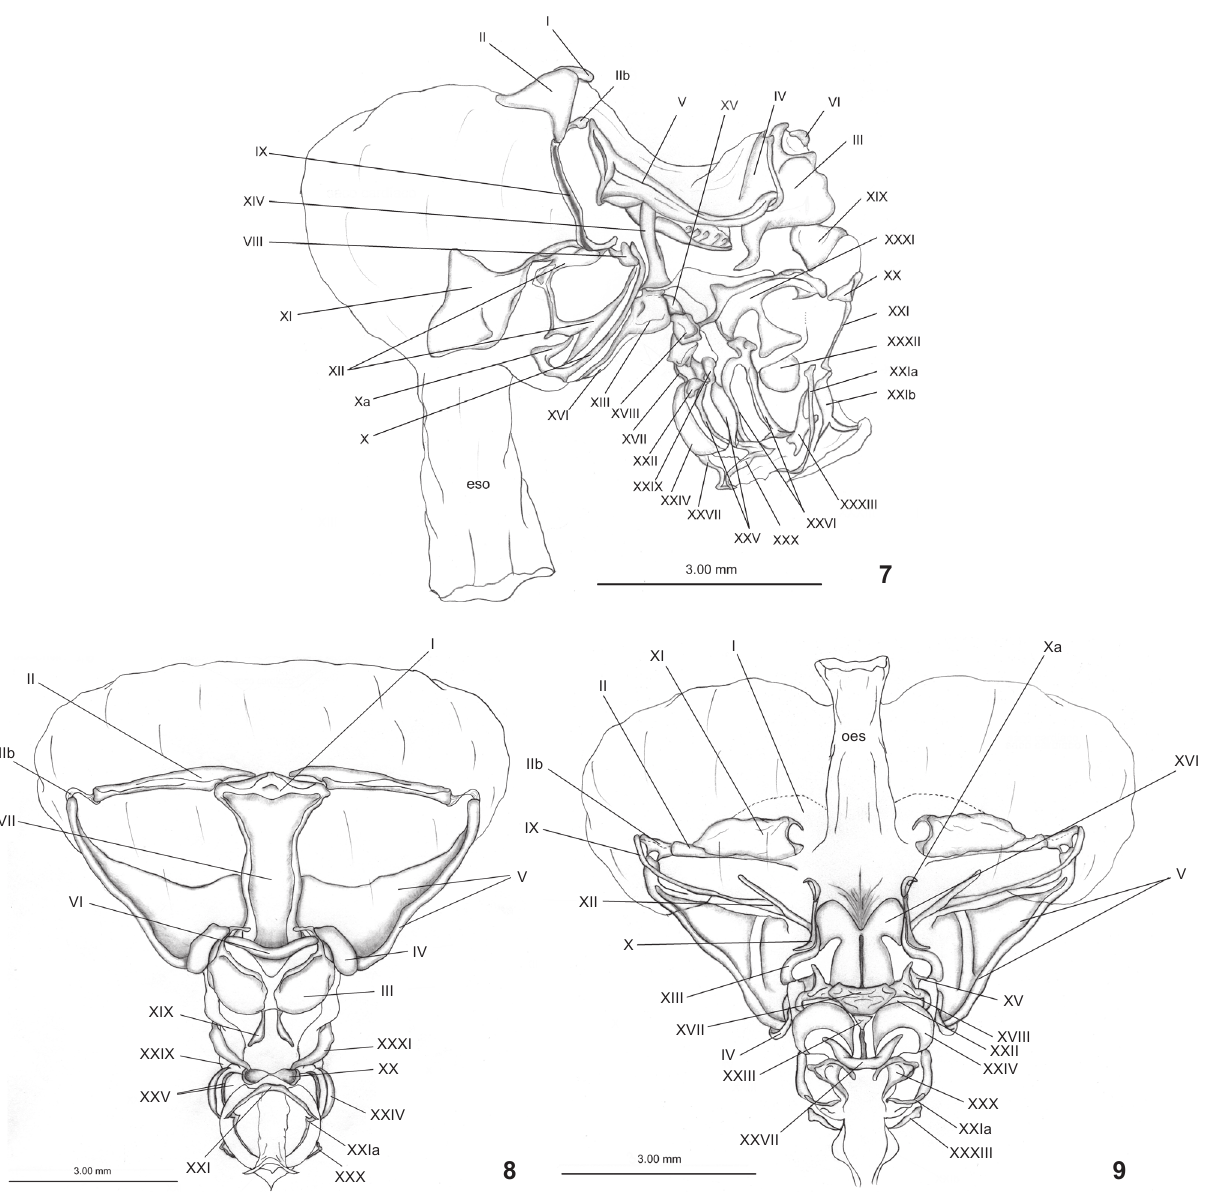
Figures 7-9. Valdivia serrata , cardiac and pyloric chambers of the foregut: (7) lateral view; (8) dorsal view; (9) ventral view. Mesocardiac ossicle (I), pterocardiac ossicle (II), postpterocardiac ossicle (IIb), pyloric ossicle (III), exopyloric ossicle (IV), zygocardiac ossicle (V), propyloric ossicle (VI), urocardiac ossicle (VII), pectineal ossicle (VIII), prepectineal ossicle (IX), postpectineal ossicle (X), ‘Quill’ of the postpectineal ossicle (Xa), anterior lateral cardiac plate (XI), posterior lateral cardiac plate (XII), inferior lateral cardiac ossicle (XIII), subdentate ossicle (XIV), lateral ossicle of the cardio-pyloric (XV), ossicle of the cardio-pyloric valve (XVI), cardio-pyloric valve (cpv), anterior ossicle of the cardio-pyloric valve (XVI), posterior ossicle of the cardio-pyloric valve (XVII), lateral ossicle of the cardio-pyloric valve (XVIII), anterior mesopyloric ossicle (XIX), posterior mesopyloric ossicle (XX), uropyloric ossicle (XXI), infra-uropyloric fragment (XXIa), posterior uropyloric ossicle (XXIb), preampullary ossicle (XXII), anterior inferior pyloric ossicle (XXIII), inferior ampullary ossicle (XXIV), ampullary roof ossicle, lower portion ossicle (XXV), ampullary roof ossicle, upper portion ossicle (XXVI), posterior inferior pyloric ossicle (XXVII), middle supra-ampullary ossicle (XXIX), posterior supra-ampullary ossicle (XXX), anterior pleuropyloric ossicle (XXXI), middle pleuropyloric ossicle (XXXII), posterior pleuropyloric ossicle